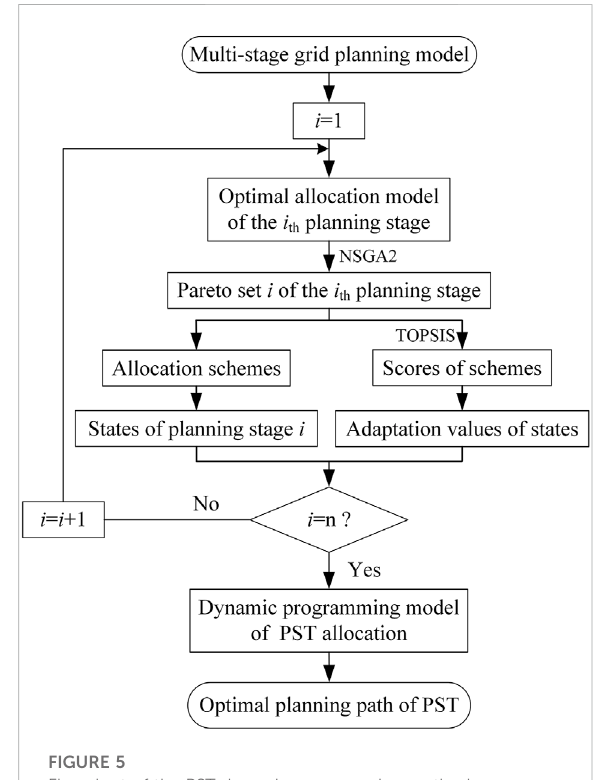
FIGURE 5 Flowchart of the PST dynamic programming